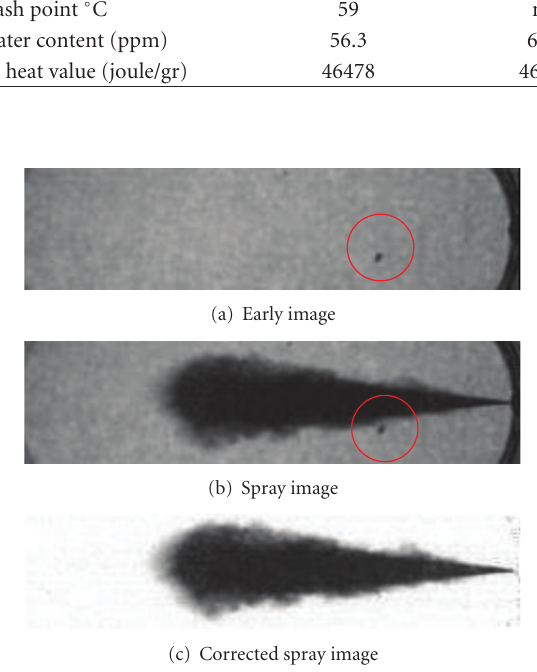
Figure 5: The illumination and fouling correction.